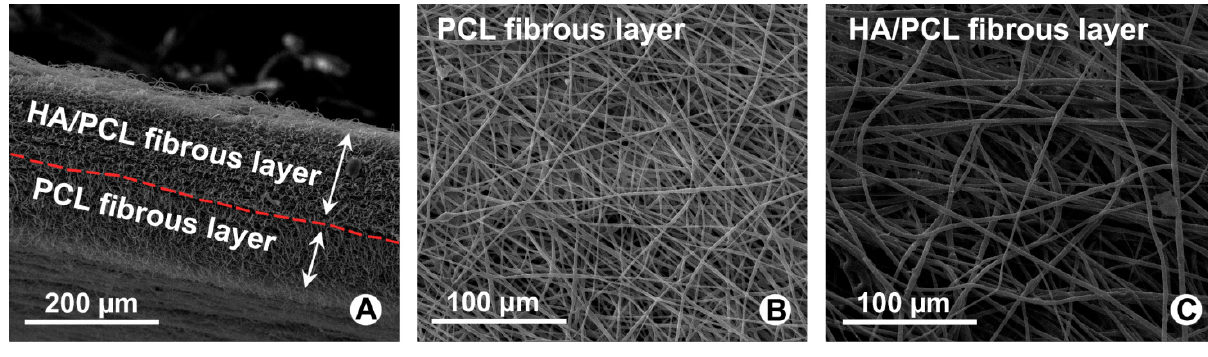
Figure 1. SEM observation for cross-sectional and surface morphological features of Polycaprolactone (PCL) fibers and hyaluronan (HA)/PCL fibers. ( A ) Cross-sectional of bi-layer electrospun fibrous membrane; ( B ) PCL electrospun fibers of outer layer; ( C ) HA/PCL electrospun fibers of inner